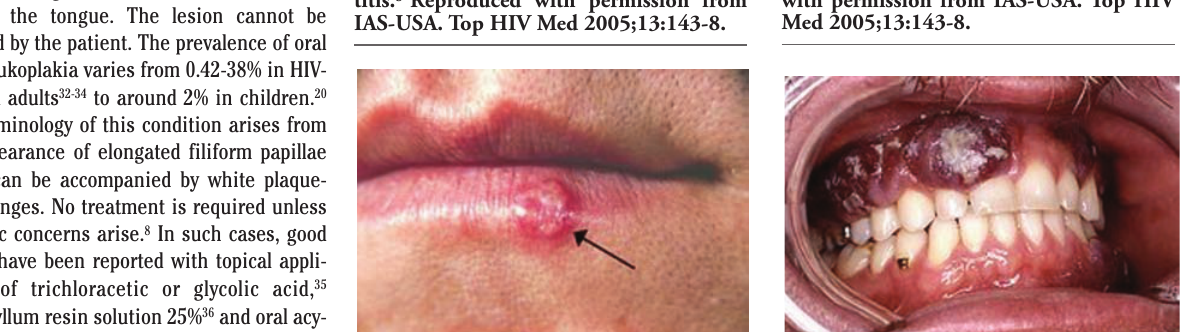
Figure 6. Oral Herpes Simplex virus. 26